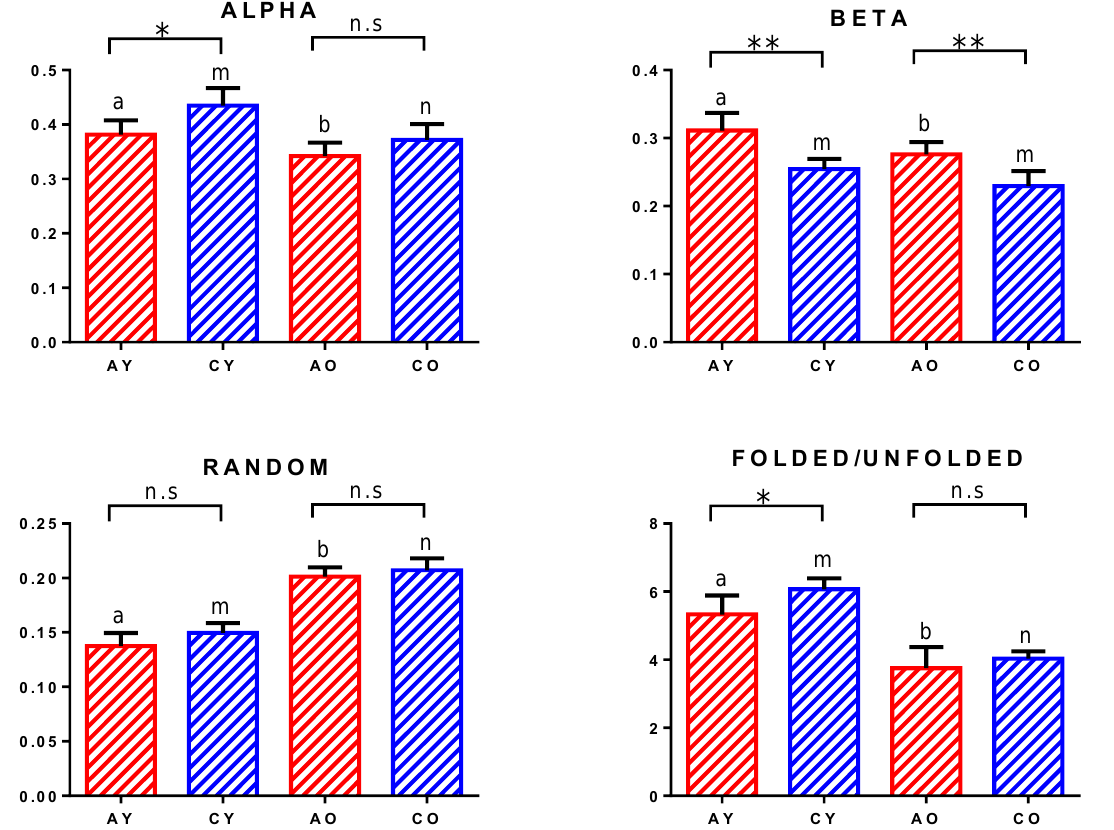
Figure 6. Statistical analysis of the protein component of AY , CY , AO , and CO samples: ALPHA ( helix structures), BETA ( β sheet structures), RANDOM (random coil structures), and FOLDED/UNFOLDED (folded to unfolded structures). Asterisks indicate statistically significant differences between A and C regions within the same group (n.s. p > 0.05; * p < 0.05; ** p < 0.01). Different lowercase letters over histograms were used to indicate significant differences between Y and O groups ( p < 0.05).